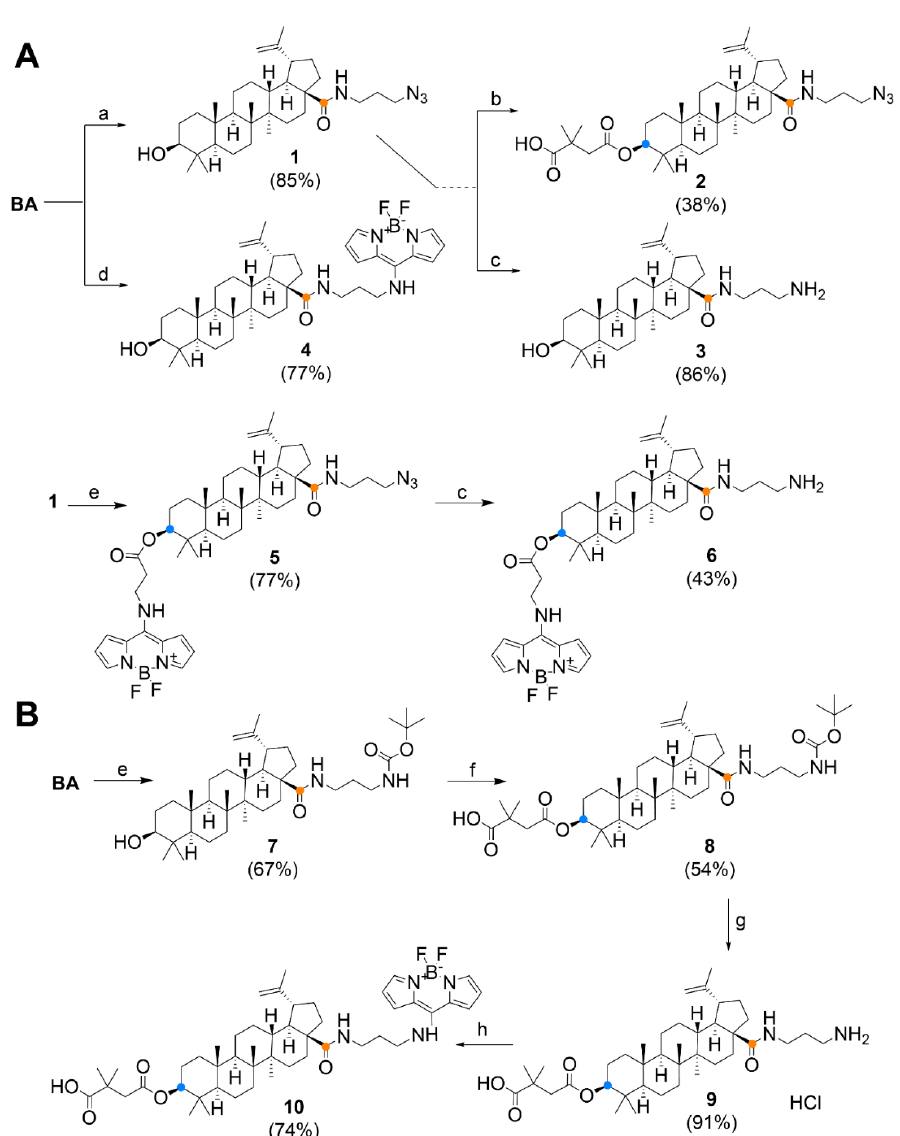
Figure 3. Synthesis of “aminopropyl” derivatives by azide reduction (panel A ) and Boc chemistry (panel B ). Reagents and conditions : (a) 3-azidopropylamine, 4-DMAP, HOBt, EDC, DMF, 36 h, RT; (b) 2,2-dimethylsuccinic anhydride, 4-DMAP, p -TsOH, THF, 2 h, MW-130 °C; (c) PPh 3 , THF/H 2 O, 23 h; (d) BODIPY-NH 2 , 4-DMAP, DCC, DCM, 12 h, RT; (e) BODIPY-CO 2 H, DCC, 4-DMAP, DCM, 12 h, RT; (f) N -Boc-1,3-diaminopropane, EDC, HOBt, 4-DMAP, DMF, 48 h, RT; (g) 2M HCl/Et 2 O, 12 h, RT (under argon); (h) BODIPY-SMe, CHCl 3 -THF, Et 3 N, 30 min, RT.